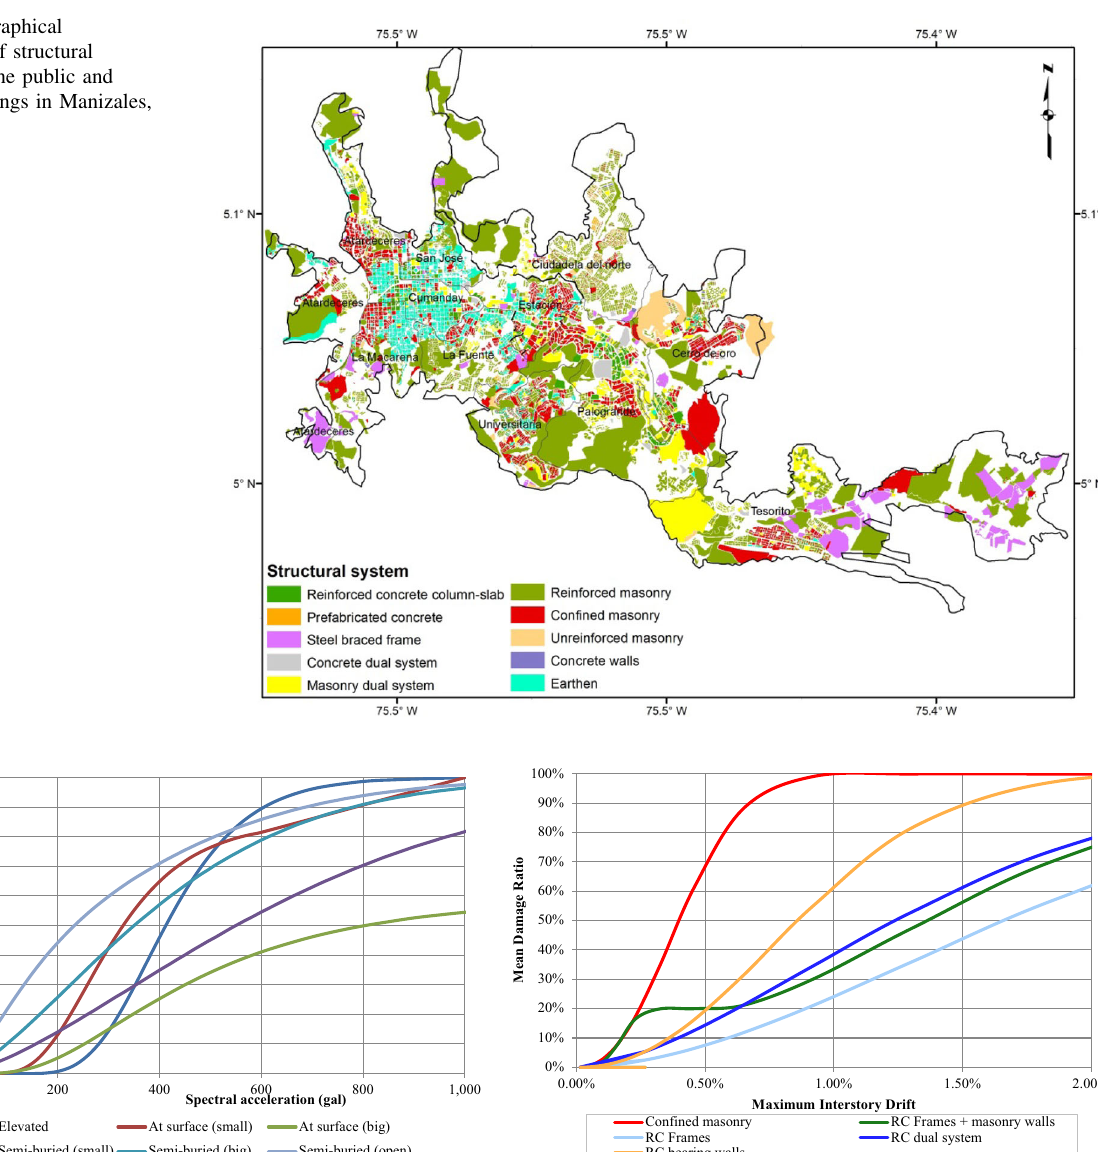
Fig. 1 Geographical distribution of structural